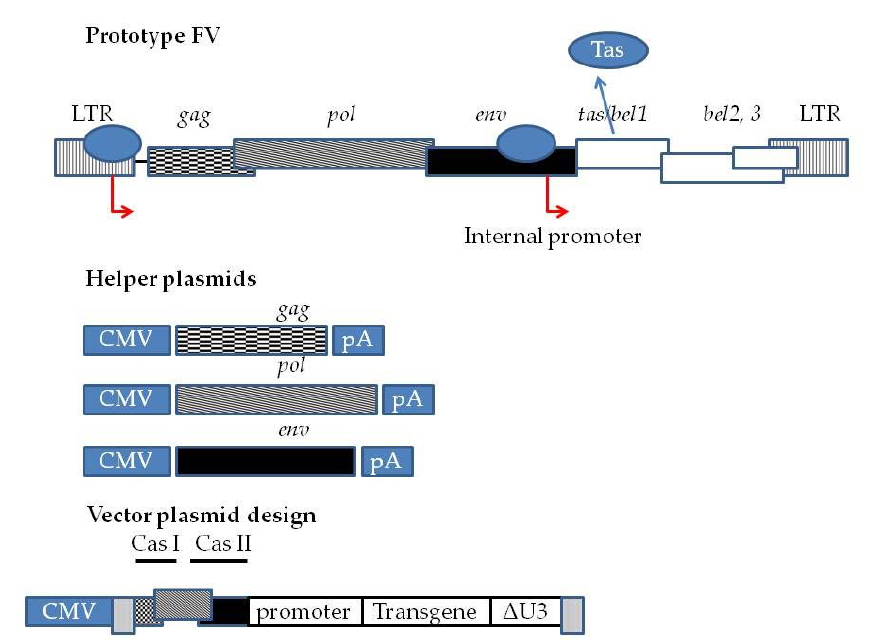
Figure 1. Third generation Foamy Virus (FV) vector system. At the top wtPFV provirus genome is depicted. The LTR contains the entire U3 region of the Human Foamy Virus (HFV.). Red arrows indicated the promoters driving the expression of FV genes, as well as the internal promoter present inside the env sequence driving the expression of tas . tas is expressed at basal levels when the provirus integrates into host cell genome. Upon translation, Tas binds to the LTR and internal promoter and enhances the transcription of gag , pol , and env. Additionally, Tas enhances the transcription of bel1 , bel2 , and bel3. bel1 and bel2 transcripts splice into a single mRNA whose translation generates Bet. In third -generation systems, the FV genome is split into a four-plasmid system comprised of three helper plasmids encoding gag , pol, and env under the control of a CMV promoter and a pA (polyadenylation signal) to allow the packaging cell lines to express the proteins at high levels. Transfer vector is comprised of deleted LTRs. Viral RNA expression is driven by a CMV promoter and an important cis ‐ acting element sequence between the 5 ′ LTR and gag , a part of the 5 ′ gag ( CAS I ) sequence, a part of the 3 ′ pol ( CAS II ) sequence and a part of the 5 ′ env sequence. These sequences are necessary for efficient virion assembly. The CMV 5 ′ LTR fusion renders the viral vector production in packaging cell lines (HEK293T) Tas independent. Moreover, there is a deletion of the U3 region of LTR. Following integration into the transduced cell genome, the Tas dependent LTR promoter is regenerated. This fact renders the vector SIN and shuts the expression driven by 5 ′ LTR off. Transgene expression is driven by internal promoters.